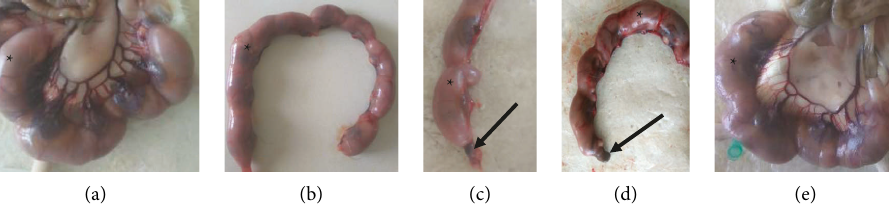
Figure 1: Gravid uterus of rat from group I, (a) group II, (b) group III, (c) group IV, and (d) group V (e) indicating implantation sites ( ∗ ) and fetal resorption (arrow) following administration of ethanol leaf extract of S. guineense . Table 3: Fetal growth indices of rat fetuses following the administration of 70% ethanol leaf extract of Syzygium guineense .